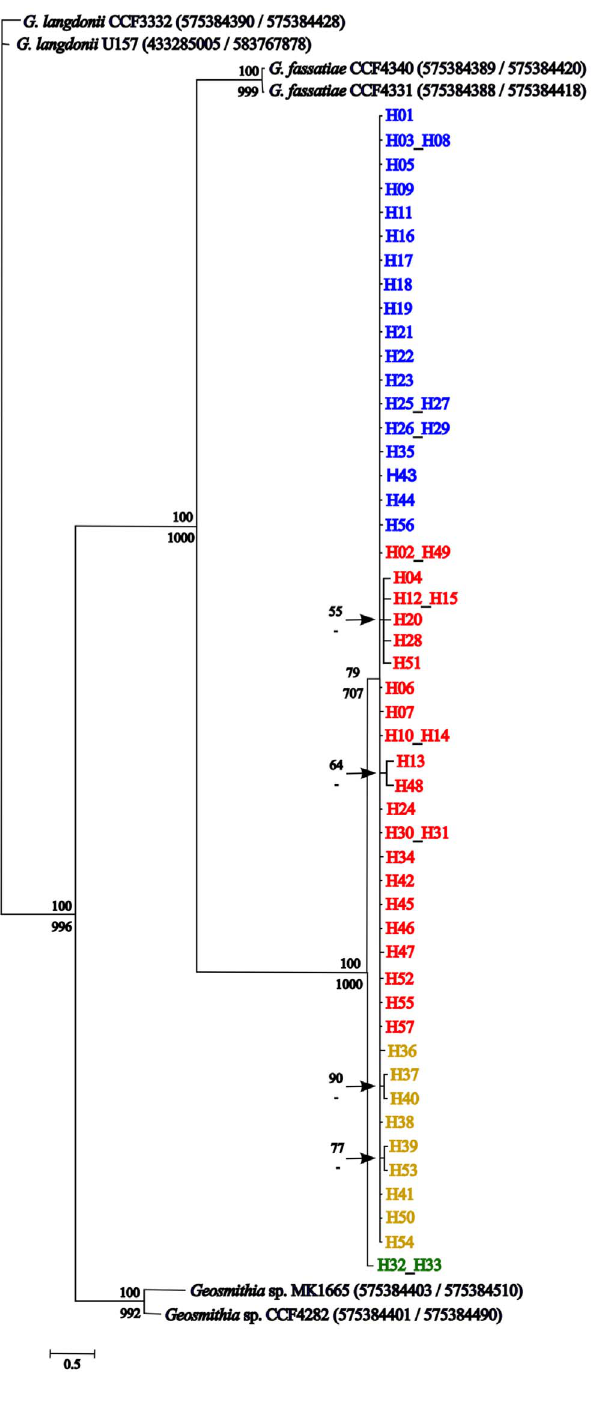
Figure 2. Unrooted phylogenetic tree of Geosmithia species based on ITS/BT sequences. A Bayesian analysis was performed for 1,500,000 generations by using a GTR-gamma distributed model of evolution (invariant sites). Bayesian percentages ( $ 50%) are depicted above each branch, and maximum likelihood bootstrap values ( $ 500) obtained by using PhyML (default parameters) are shown below most branches. Geosmithia morbida haplotypes are color coded according to their genetic cluster assignment (four-cluster-MLST-DAPC model, as in Figure 3) and haplotypes sharing the same ITS and BT sequences are co-located. Leaves pertaining to the same branch were arranged together according to their cluster assignment. GenBank accession numbers of other Geosmithia spp. are identified within